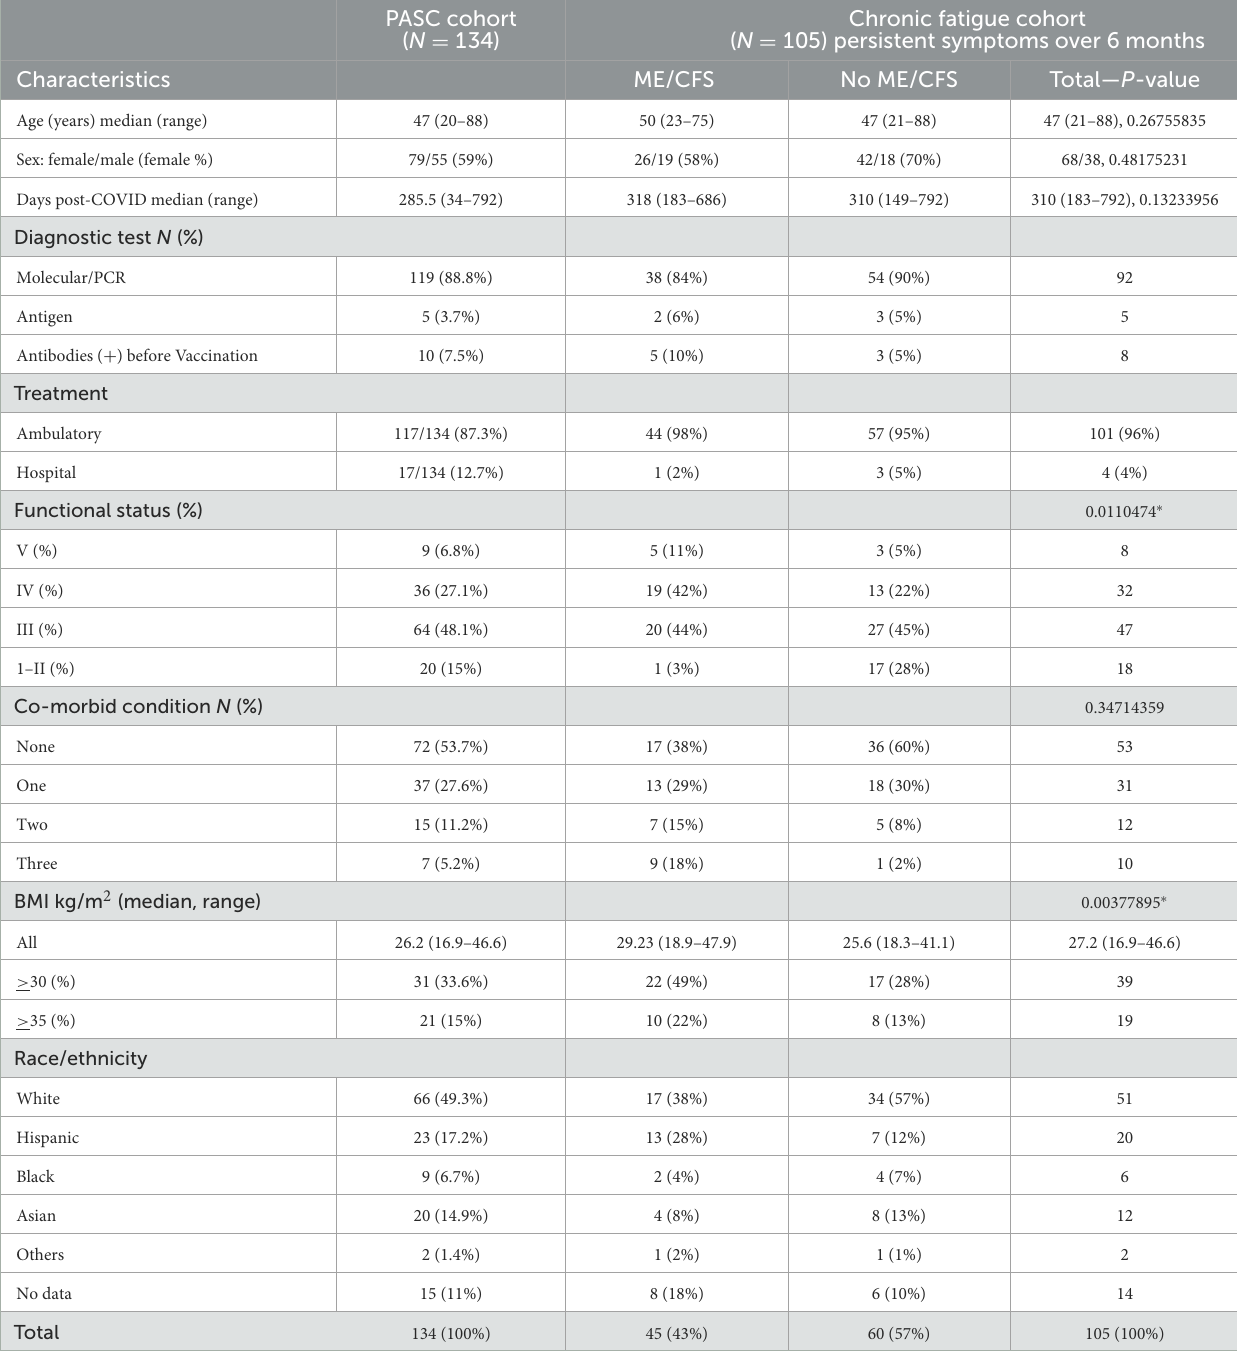
TABLE 1 Patient’s characteristics and distribution PASC cohort and chronic fatigue cohort.